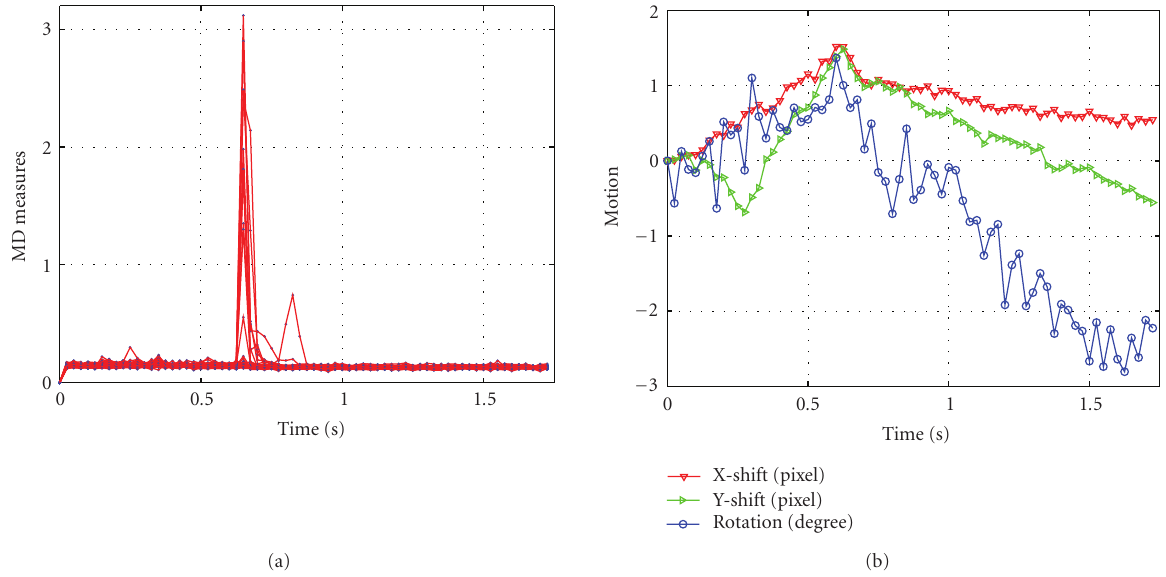
Figure 11: (a) Manifold-distance measurements across time; (b) the corresponding motion of the centerline of the beam.